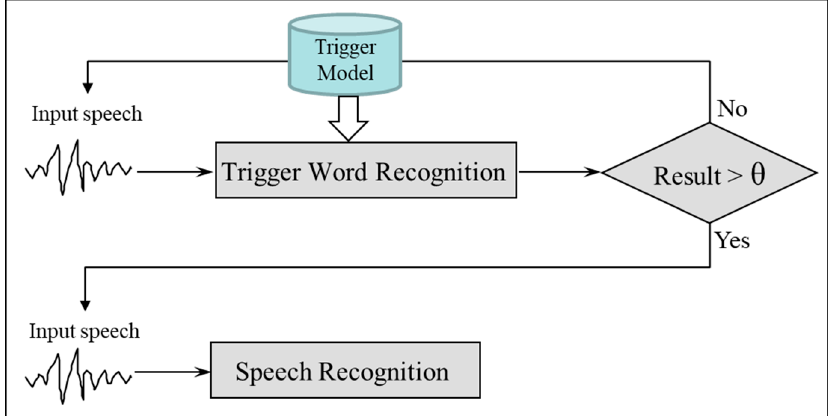
Figure 6. Conventional voice trigger method.